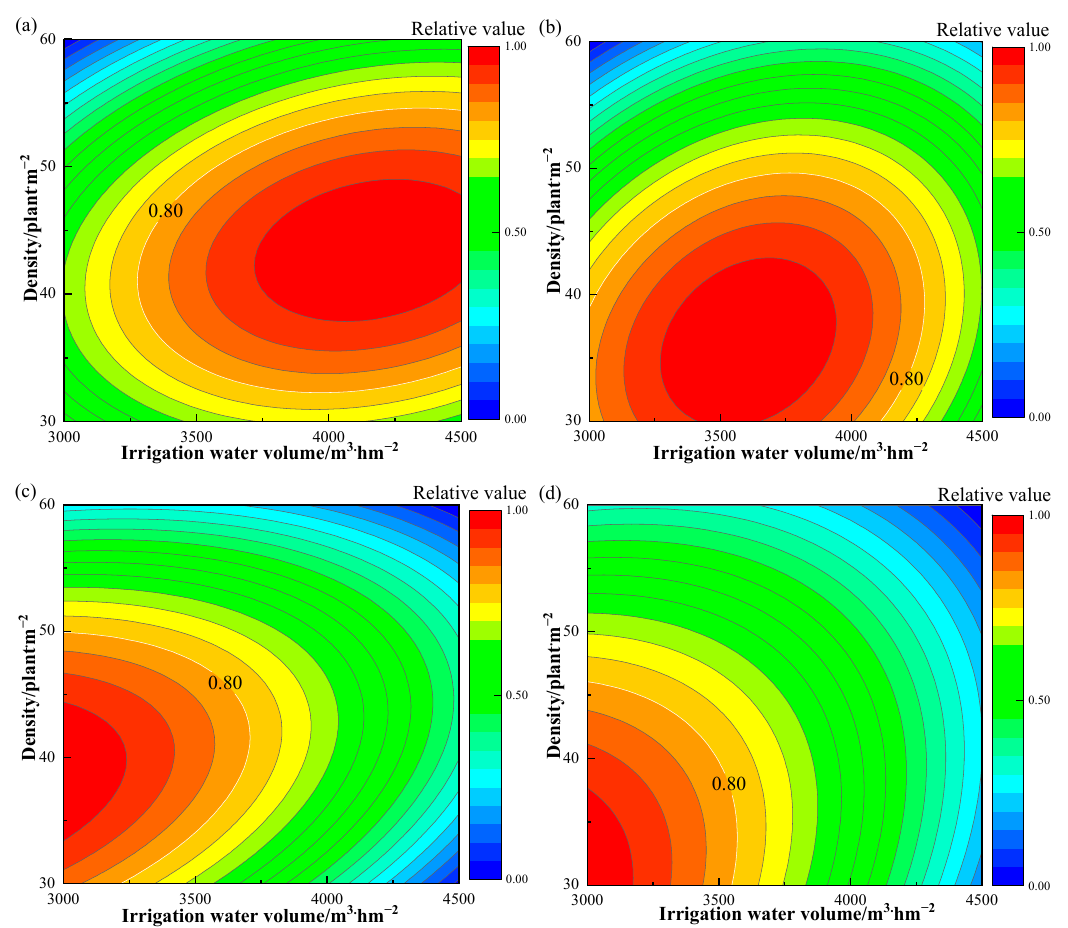
Figure 2. Contour maps of the relationship between each evaluation index at different irrigation volumes and densities. In the figure ( a – d ) represent biomass, salt uptake, WUE and WSE, respectively.